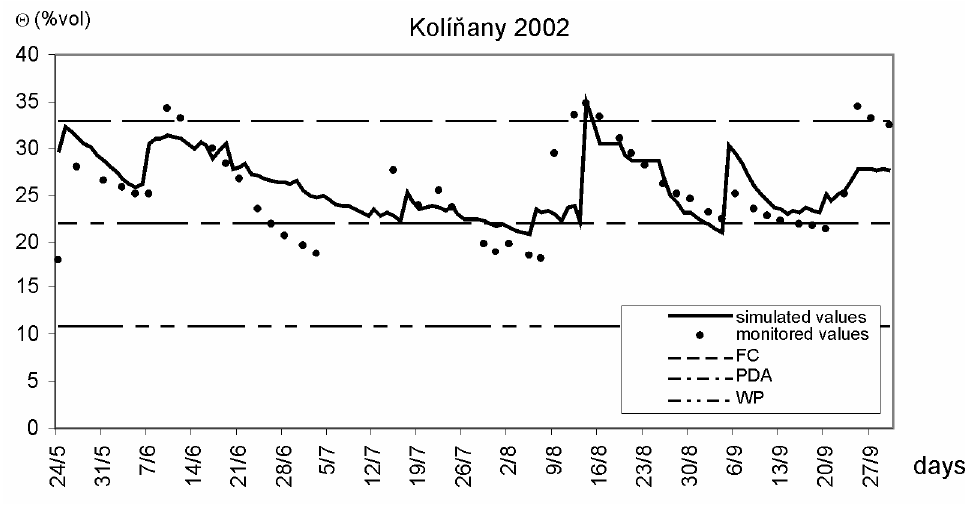
Fig 1. Measured and simulated values of volumetric soil water content in study area of Kolí ň any in 2002